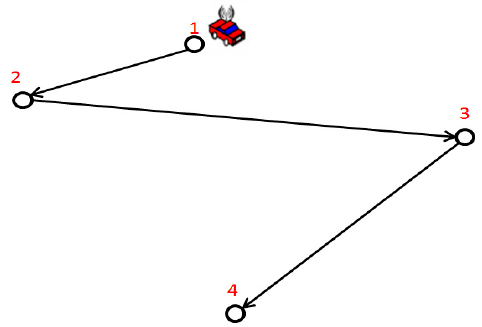
Figure 2. An example of a charging path.